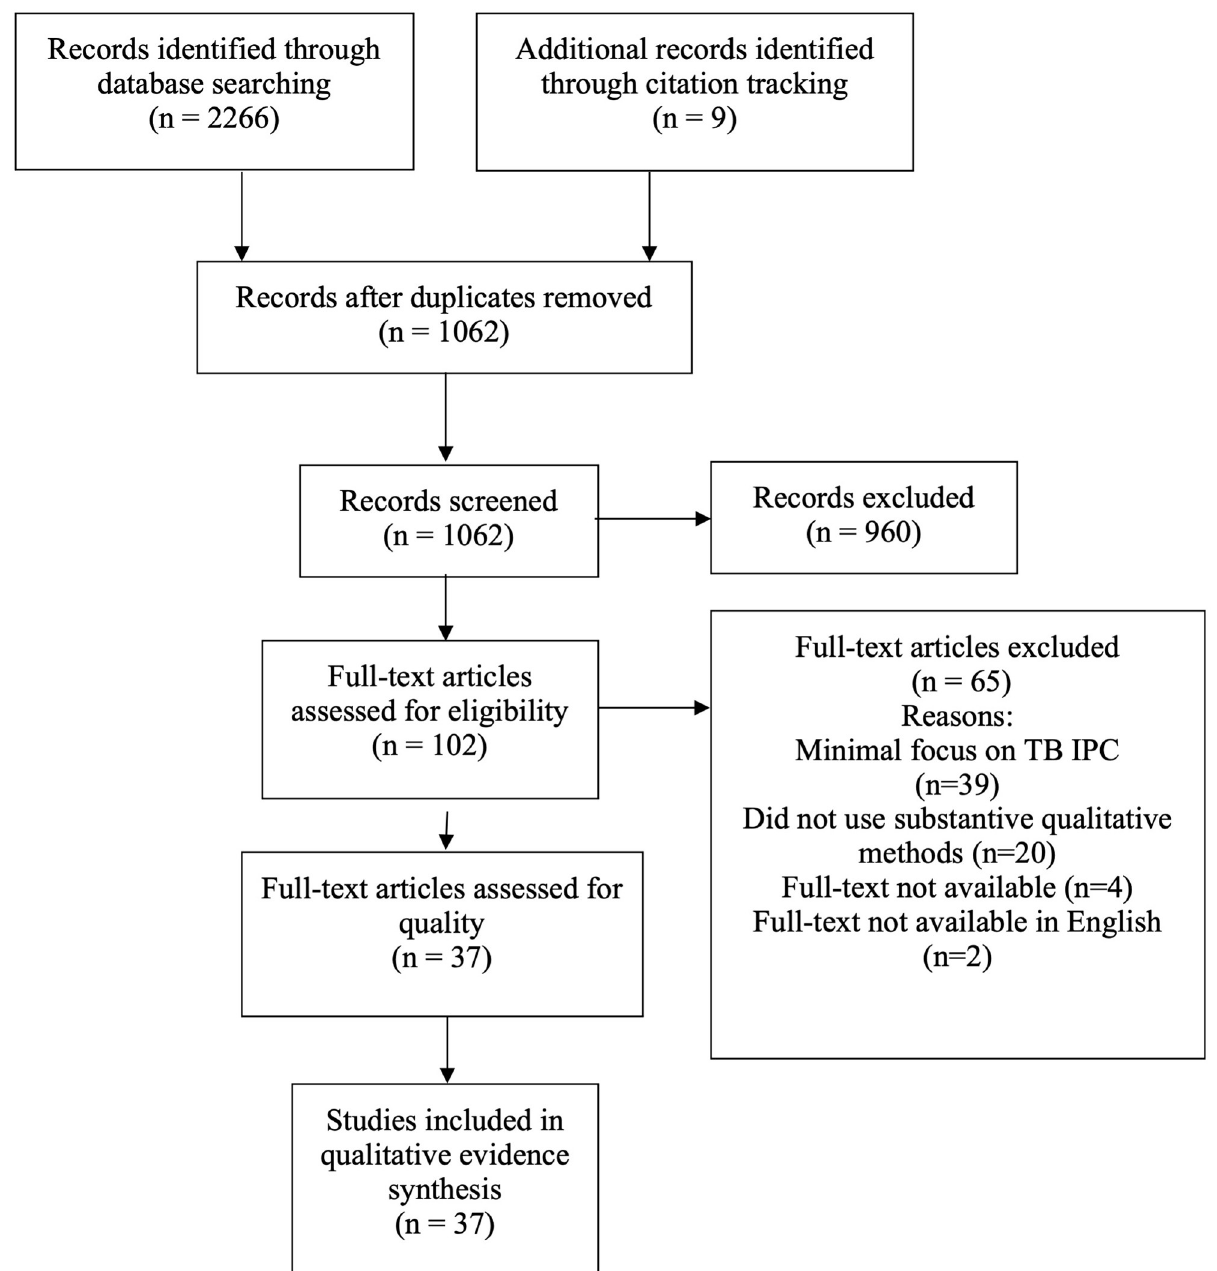
Fig 1. PRISMA flow